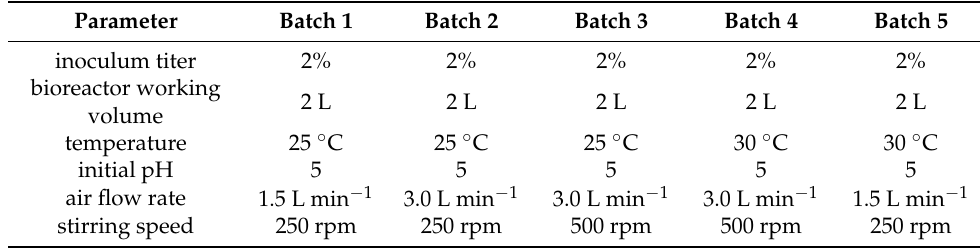
Table 6. Parameters of five batch cultures in a 4.8 L